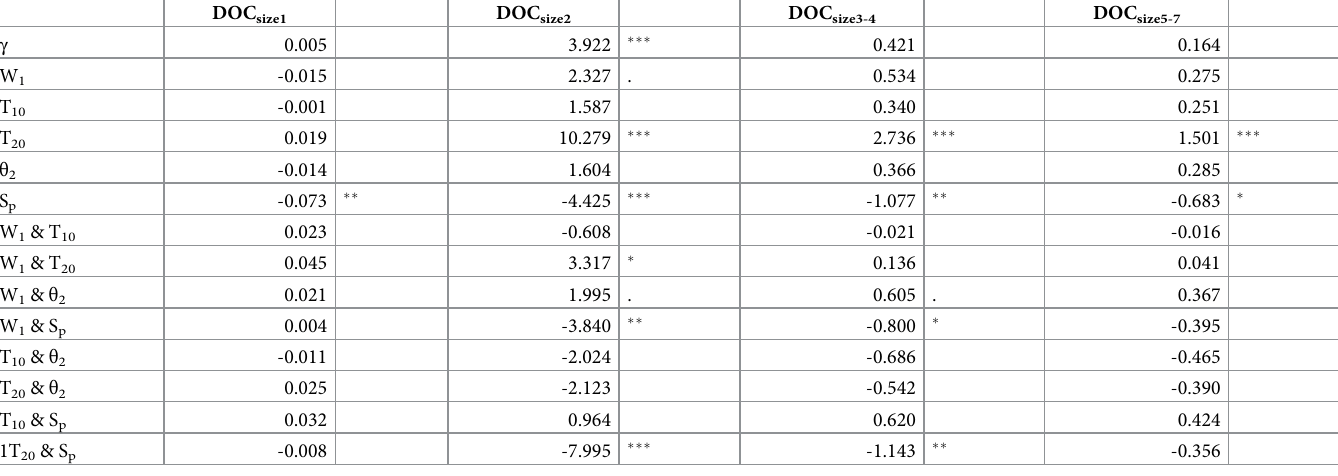
Table 4. Change rate ( μ g g -1 day -1 ) in different DOC molecular-size pools during the incubation (Eq 1). Parameter γ represents the change rate for mor (S m ), no worms (W 0 ), lower moisture status ( θ 1 ) at 5˚C temperature (T 5 ). The other treatment effects and the interaction effects (from W 1 to T 20 & S p ) are expressed as a difference with respect to γ . Molecular size decreases from size class 1 to size class 7. DOC size1 and DOC size2 belong to